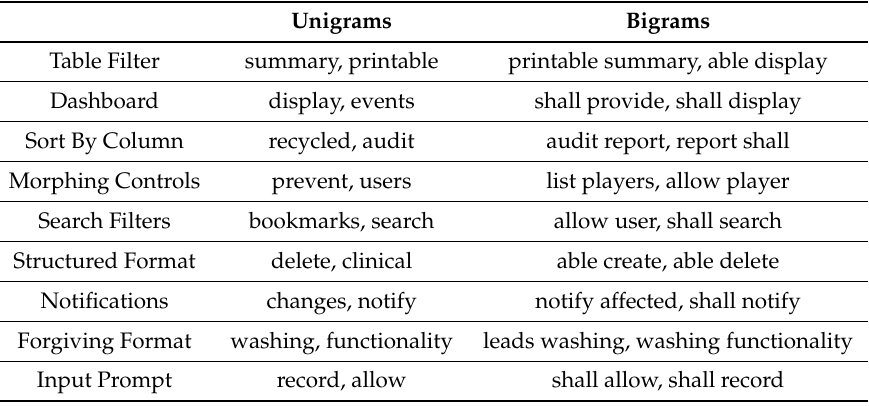
Table 2. Unigrams and bigrams of the functional requirements dataset.